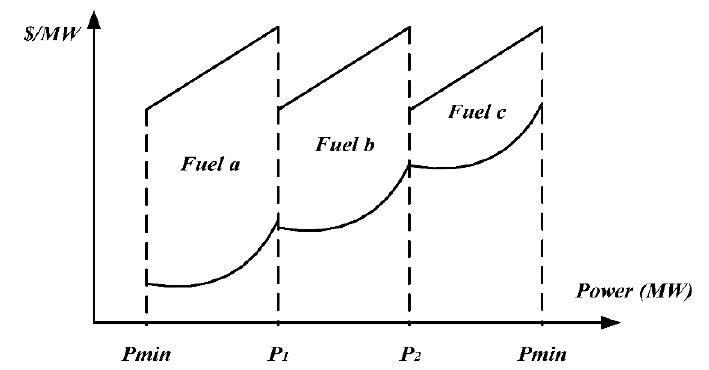
Figure 3. Fuel cost curve for PED problem with Multiple Fuel Options (MFOs).